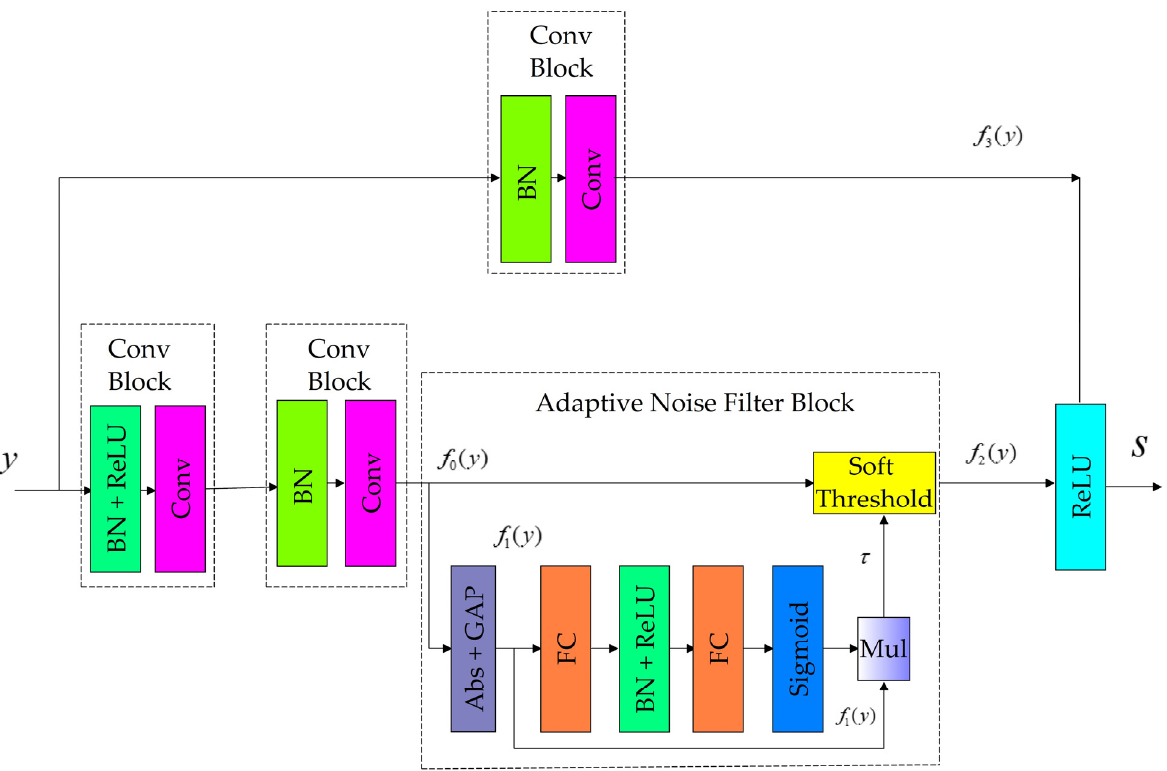
Figure 1. The 1D residual shrinkage building unit (RSBU) of the DRSN structure. We insert the adaptive noise filter layer into the ResNet block. y is the input MT data. BN represents the batch normalization layer. ReLU represents the rectified linear unit layer. Conv represents the convolutional layer. Abs represents the absolute operation processes. GAP is an operation layer that calculates a mean value. FC represents the fully connected layer. f represents the feature obtained by domain transformation. S is the output MT signal. Mul denotes the multiplication of corresponding positions.